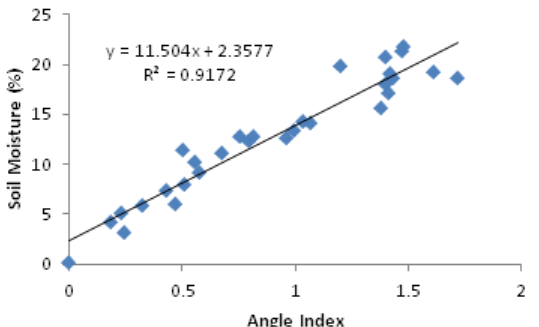
Fig. 11 Relationship between angle index in the SWIR region (2150nm to 2155nm) and soil moisture